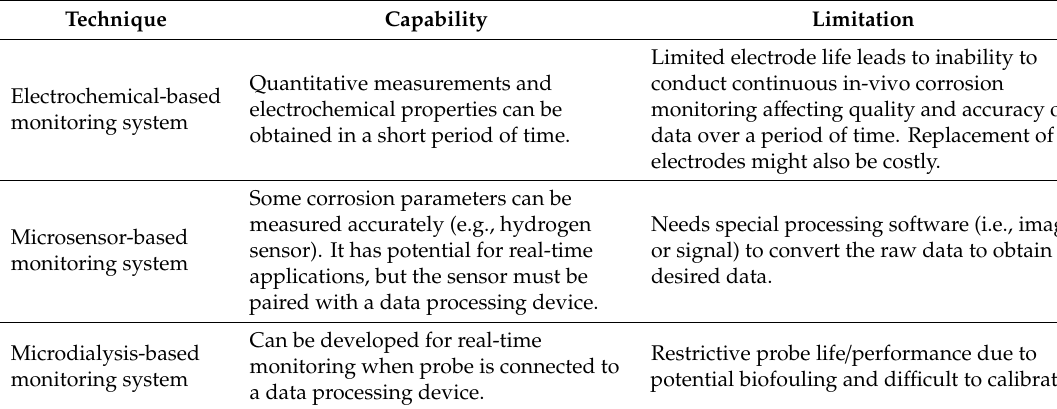
Table 2. Capabilities and limitations comparison of the real-time in-vivo corrosion monitoring techniques